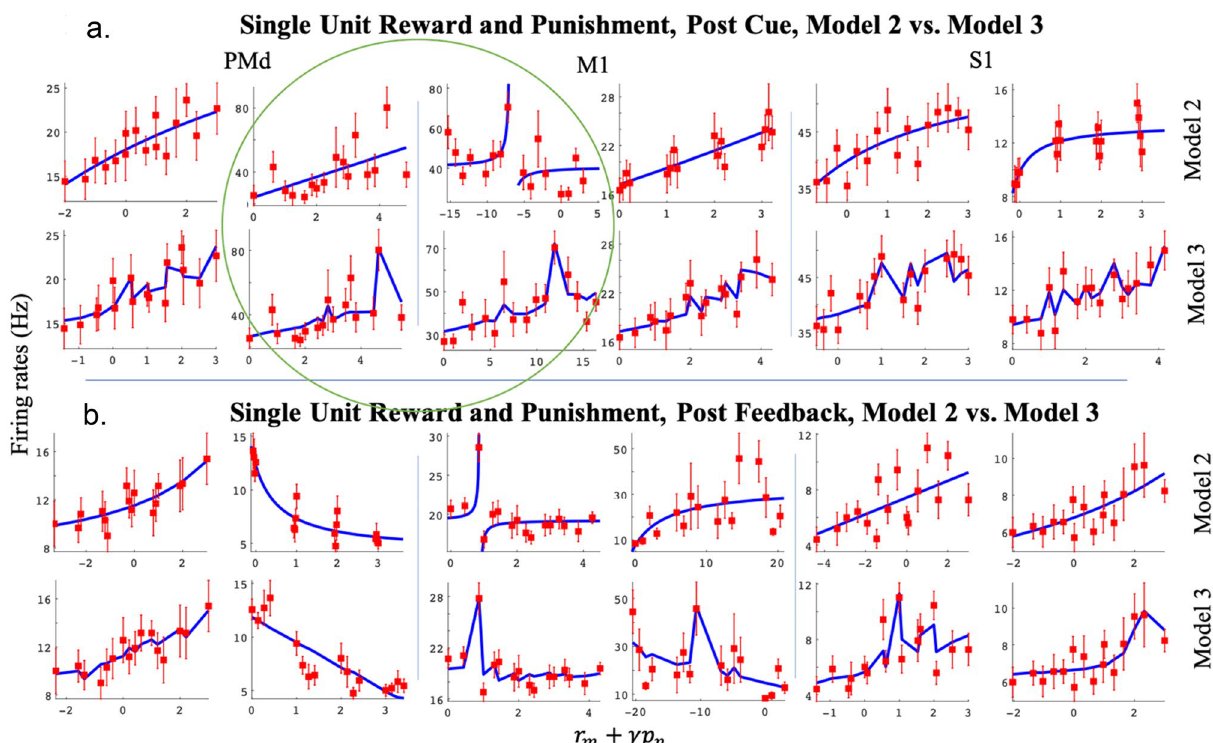
Figure 6. Post-cue ( a ) and post-feedback ( b ) example units for model 2 (top rows in each subplot) and model 3 (bottom rows in each subplot). The x-axis represents the affective stimuli, a linear combination of reward and scaled punishment r m + γ p n , where γ is fit to the data. The y-axis represents the post-cue ( a ) and post-feedback ( b ) firing rate (Hz). The mean ± SEM of the firing rates (red) and the mean for the model (blue) are shown. Each column represents one unit, fit to model 2 (top) and model 3 (bottom) rows. The first two columns show units from PMd, the third and fourth columns from M1, and the last two columns from S1. All units shown here were significant (see